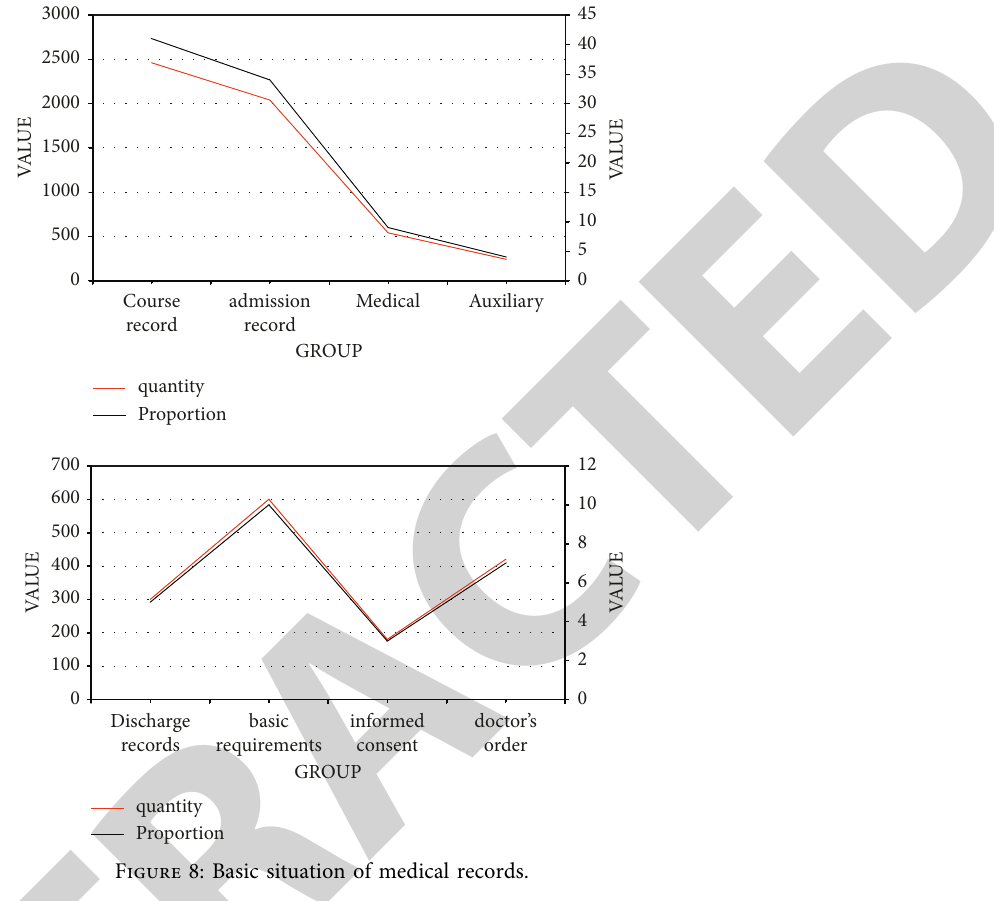
Figure 8: Basic situation of medical